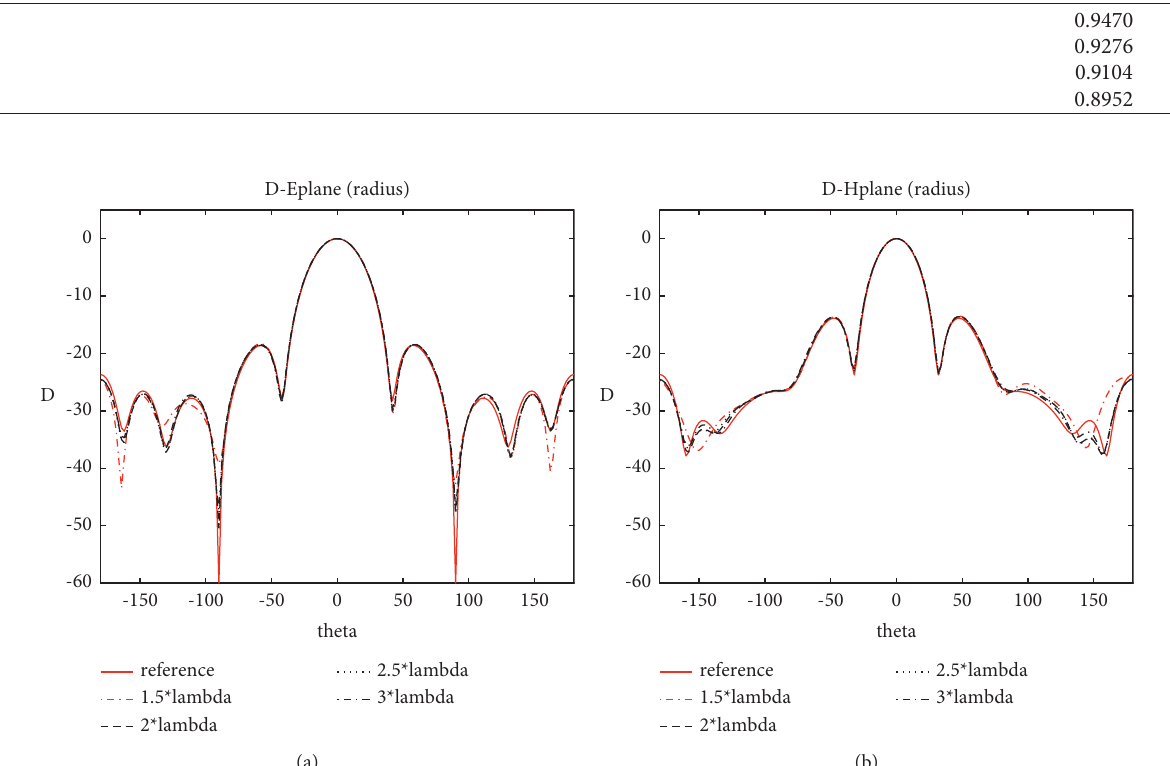
Figure 7: Radiation pattern of the dipole array corresponding to the nine sampling methods. (a) Radiation pattern corresponding to two spheres with the same distribution forms. The left and right sides of the figure represent E-plane and H-plane, respectively. (b) Radiation pattern corresponding to two spheres with different distribution form. The left and right sides of the figure represent E-plane and H-plane, respectively. Table 3: Correlation of the measurement matrix corresponding to different radius difference. Radius difference/ λ